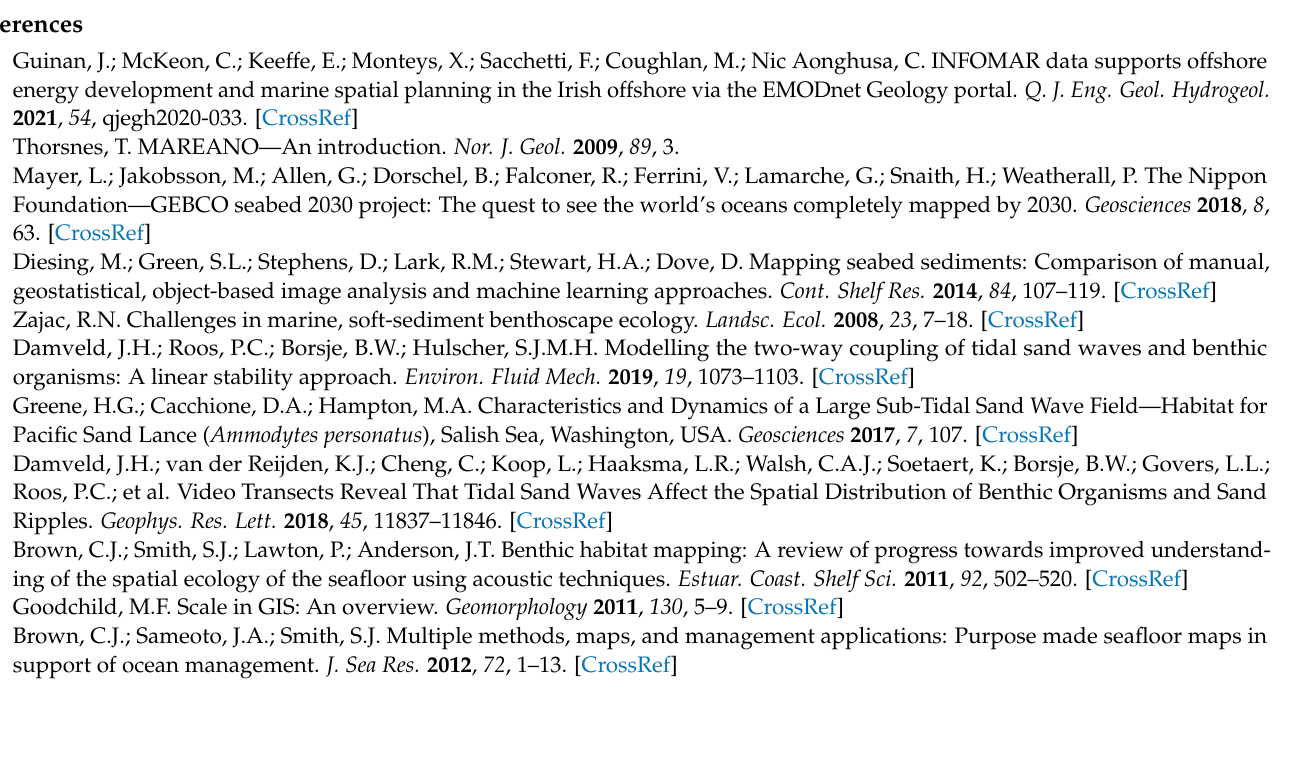
for the SE OSW, Figure S3: Confusion Matrices for the SW OSW, Shapefile S1: HTB SAC Outline, Shapefile S2: OSW